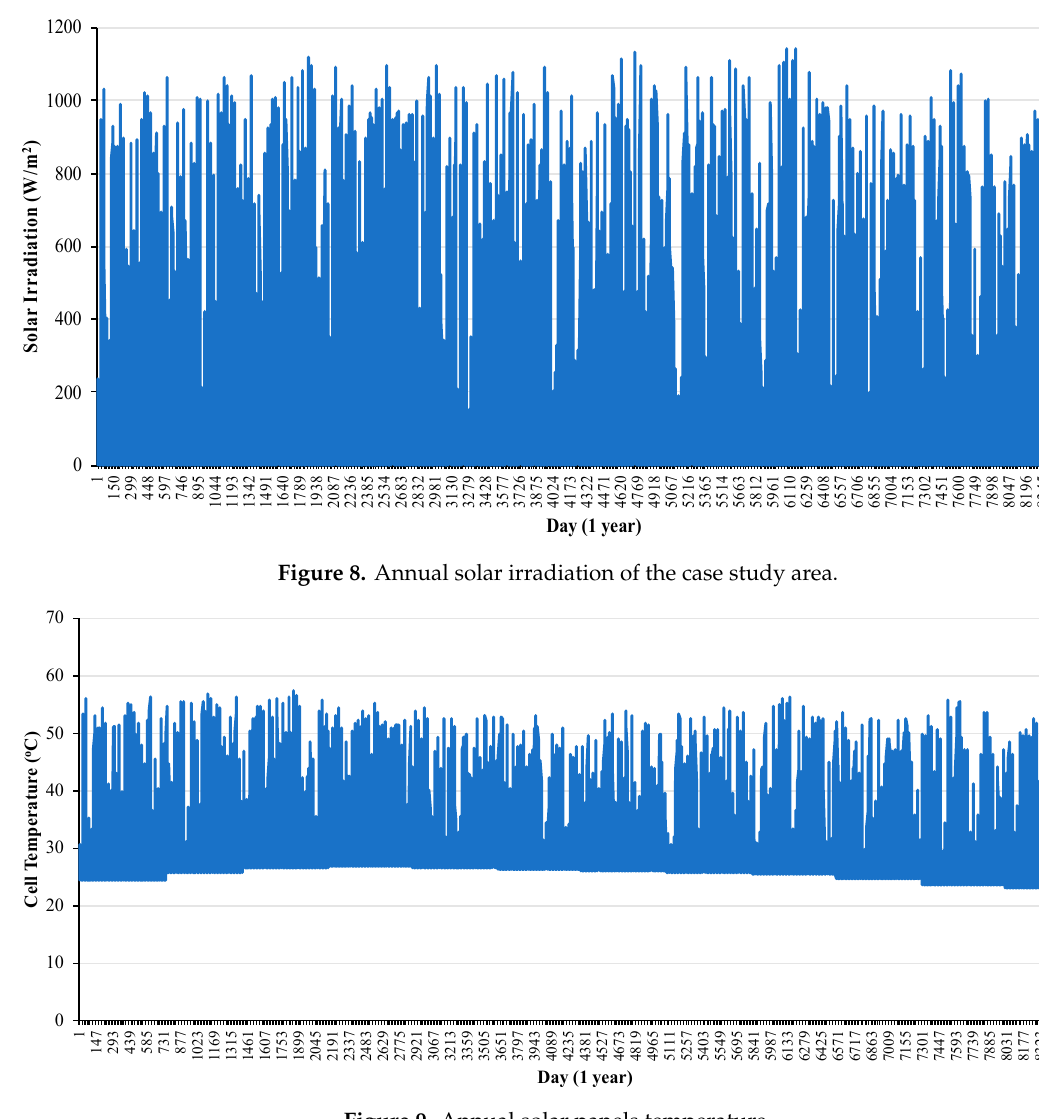
Figure 9. Annual solar panels temperature.